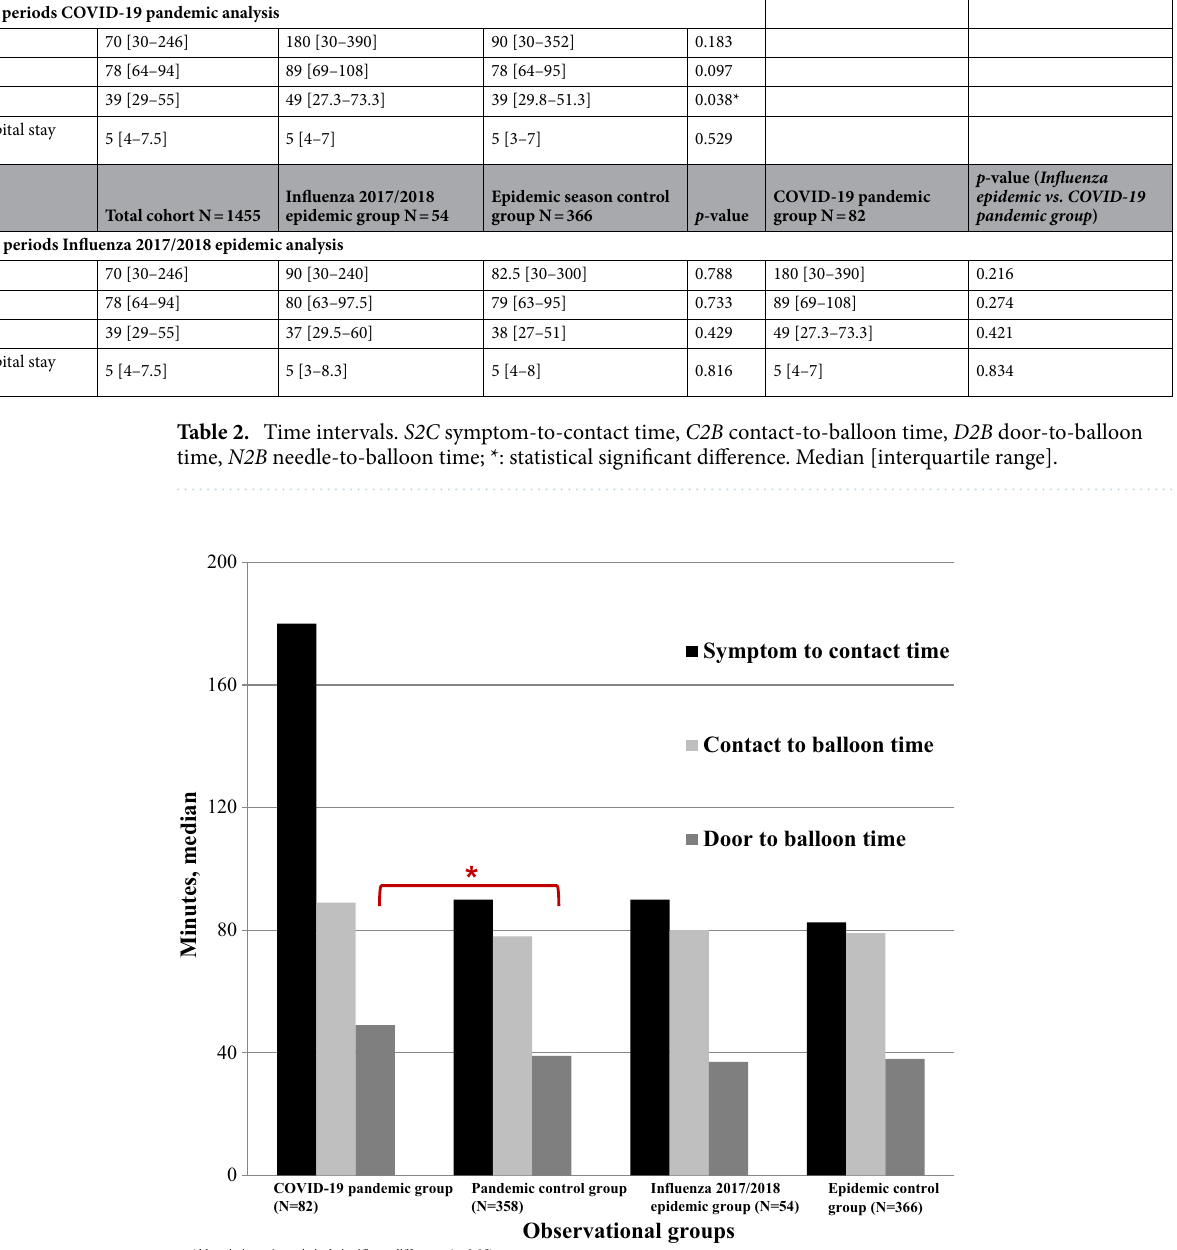
COVID-19 pandemic group N = 82